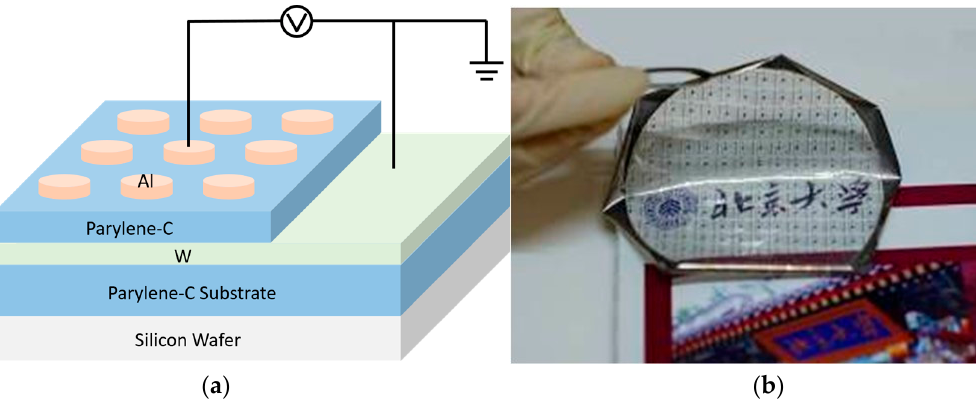
Figure 1. ( a ) Schematic of the fabricated flexible Al/ polychloro-para-xylylene (parylene-C)/W device; ( b ) Picture of the fabricated device with excellent flexibility and transparency.